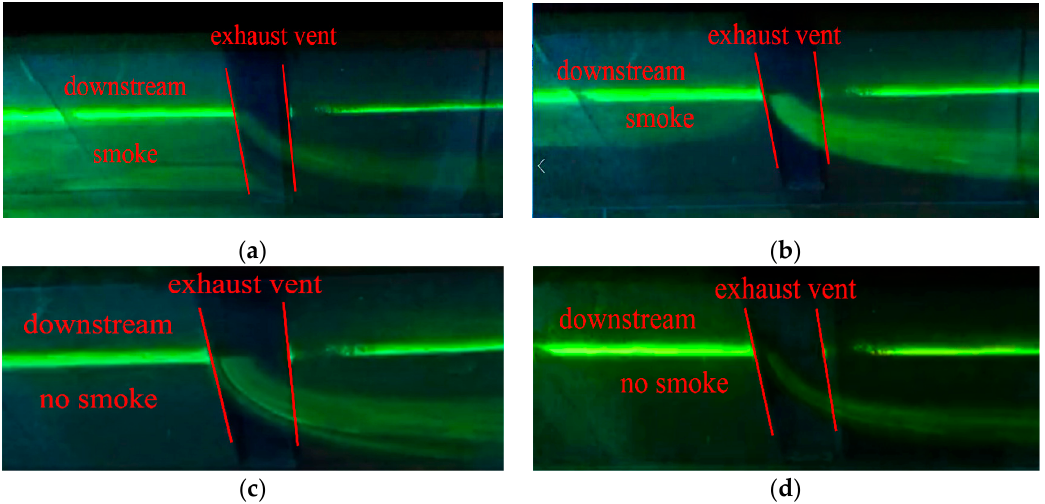
Figure 10. Smoke configurations with different exhaust volumetric flow rate for Test No. 6–9 in Table 2. ( a ) 15 m 3 /h; ( b ) 17.5 m 3 /h; ( c ) 18 m 3 /h; ( d ) 18.5 m 3 /h.